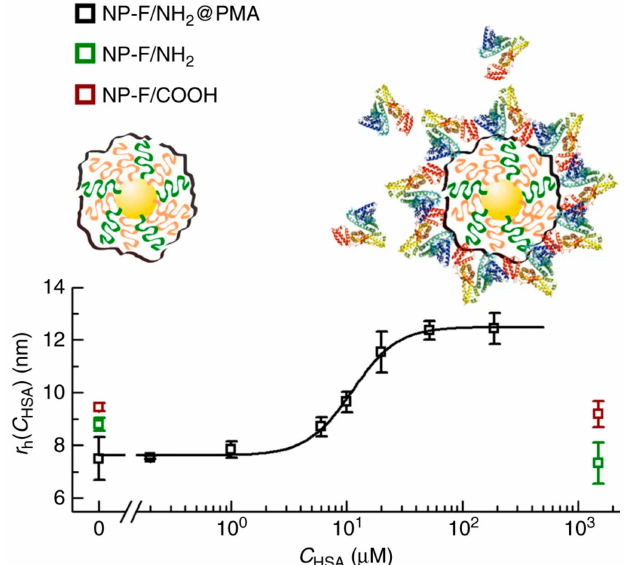
Figure 18. Study of size changes due to Human Serum Albumin (HSA) protein corona formation on fluorinated nanoparticles (NPs) with amino groups (green), carboxyl groups (red), and coated with polycarboxylated polymer (black). Reprinted with permission from reference [9]. Copyright (2017) Springer